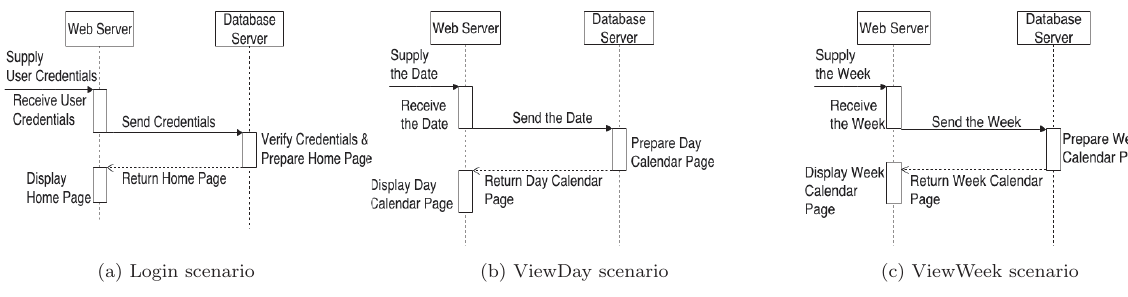
Figure 2: Message sequence charts of WebCalendar requests